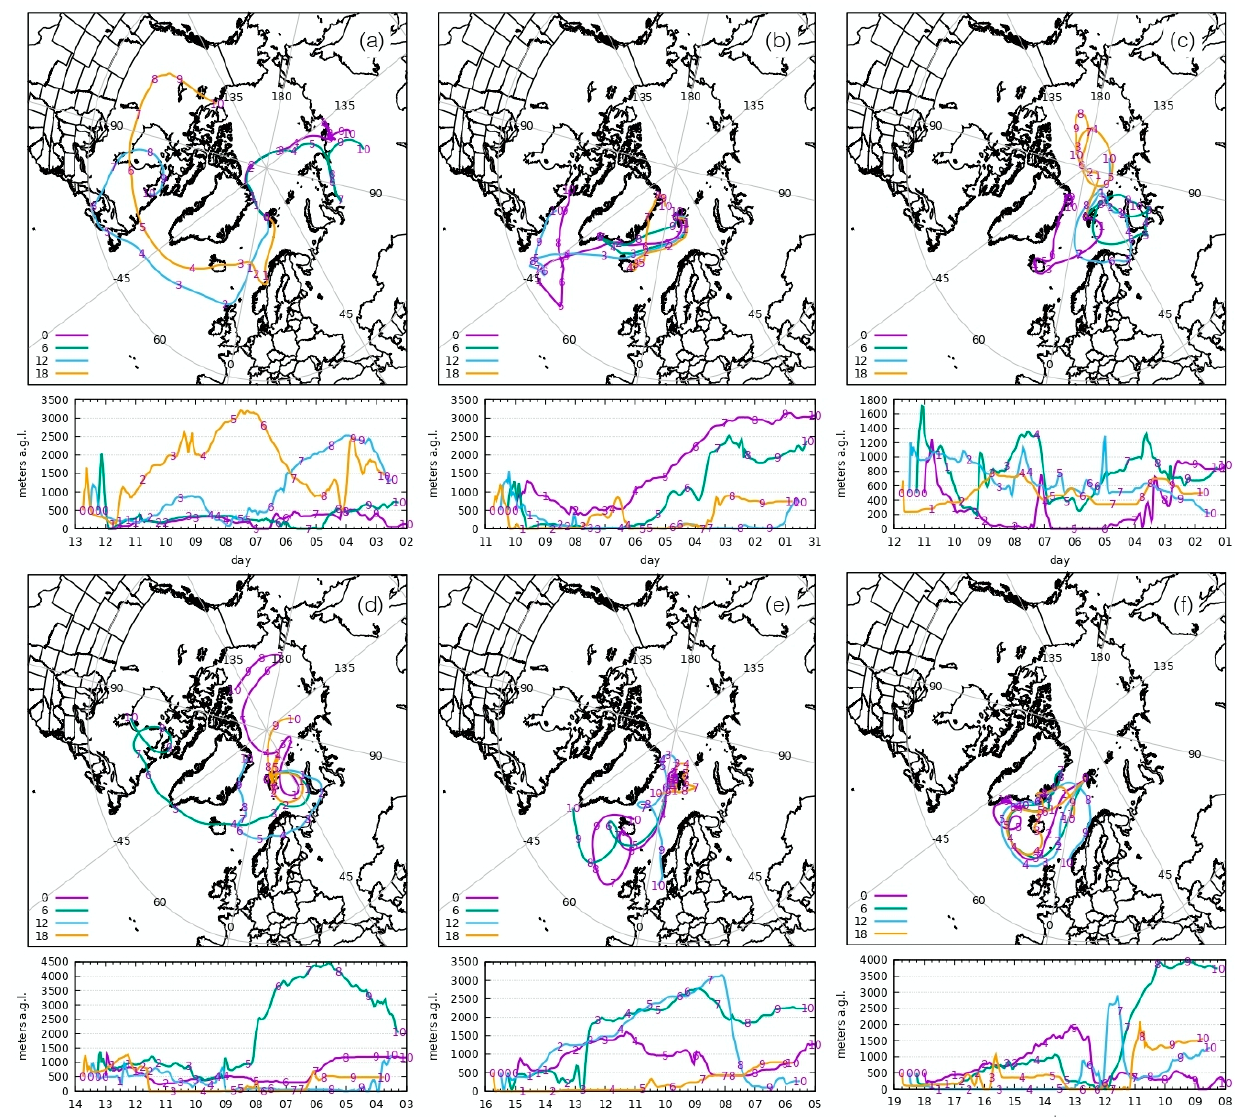
Figure 6. Plots of 240 h back trajectories of 12 March ( a ), 10 June ( b ), 11 June ( c ), 13 June ( d ), 15 August ( e ), and 18 August ( f ), 2015 ending at 0, 6, 12, and 18 UTC upon Ny-Ålesund. The position at 00:00 of each elapsed day is specified by the small number along the paths.